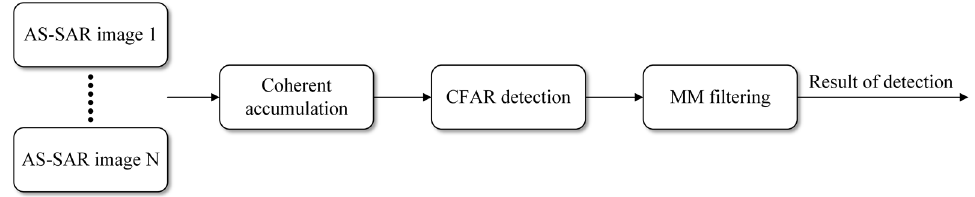
Figure 4. The practical detection flow of SAR images.